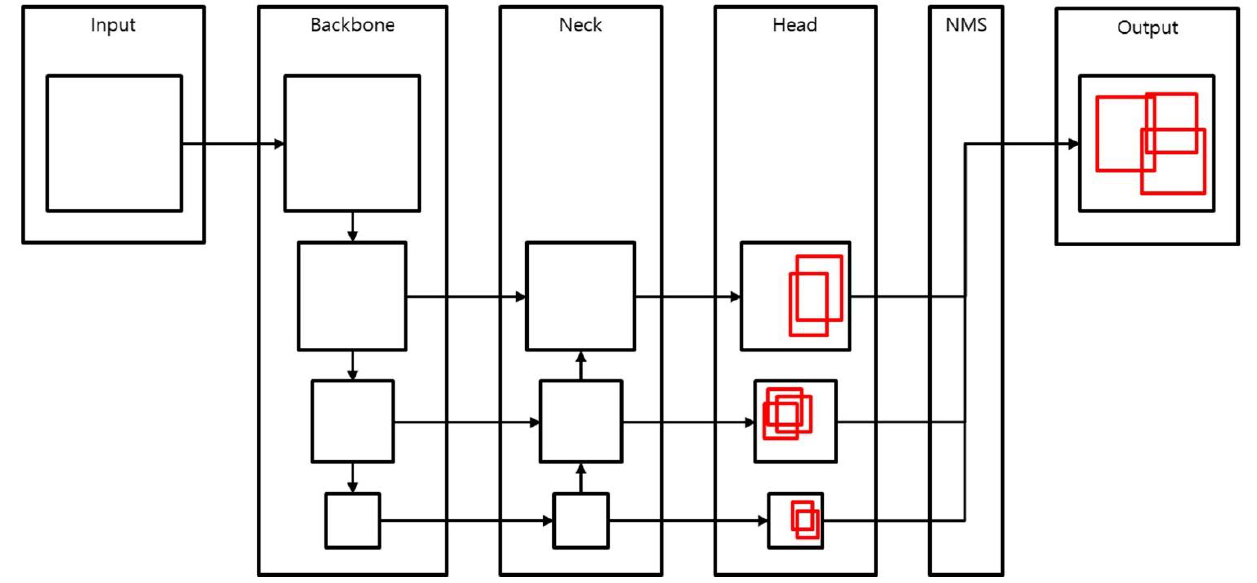
Figure 11. YOLOv4 and YOLOv4-tiny generalized architecture.